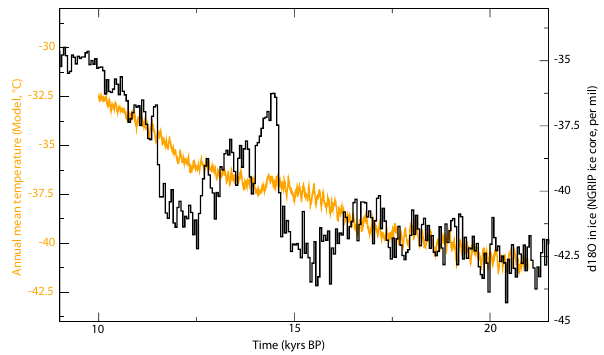
Fig. 3. General outline of the deglaciation simulation: comparison of the modelled annual temperature (yellow) at North Grip (North Greenland Ice Core Project members, 2004) to the North Grip δ 18 O record (black). The δ 18 O of the ice is scaled so as to have a 10 ◦ C warming during the Bølling